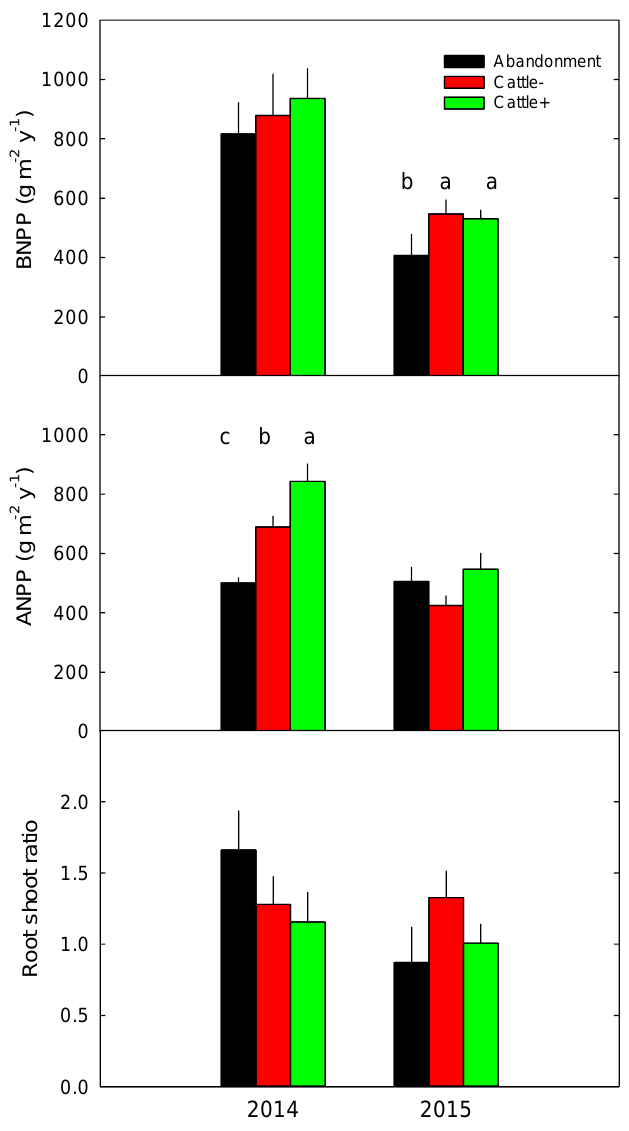
Figure 2 . The annual root biomass production (BNPP, g m -2 y -1 ), annual above-ground biomass production (ANPP, g m -2 y -1 ), and root-to-shoot biomass ratio measured in 2014 and 2015 for the abandonment, low (Cattle- ), and high (Cattle+) grazing intensity treatments. The vertical bars correspond to 1 SE (n = 4). Within a year, different letters correspond to significant differences at P <